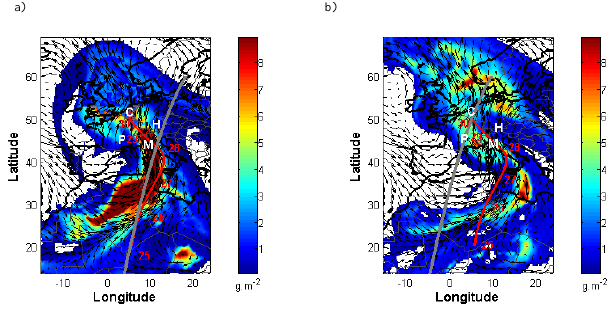
Figure 1. Dust load (shading, gm − 2 ) and 700hPa wind (vec- tors) simulated by Meso-NH at 12:00UTC on (a) 28 May and (b) 29 May 2008. Nighttime CALIPSO overpasses are indicated by the gray line. Six-day backward trajectories calculated during the 25– 30 May 2008 period are indicated by the red line. The locations of the Cabauw, Puy de Dôme, Hohenpeißenberg and Mont Cimone sites are indicated by C, P, H and M